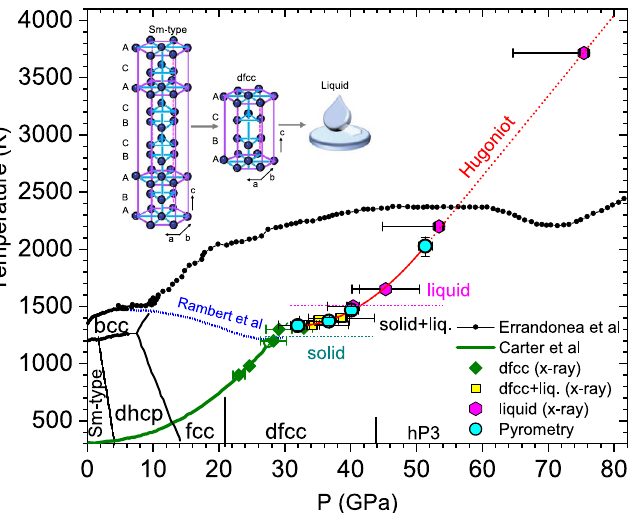
Figure 9. Proposed phase diagram of Samarium showing the solid-liquid phase boundaries. The uncertainties in pressures are presented in Table 1. Cyan circles are measured temperatures from pyrometry measurements. Green diamonds represent the solid dfcc phase, the yellow squares are the dfcc+liquid phase, and the magenta hexagons are the liquid phase from current XRD study. Small filled circles indicate the DAC melt curve proposed by Errandonea et al. 14 . The solid black lines are phase boundaries from various DAC studies 11,13 . Blue dashed line is the proposed melting curve by Rambert et al 13 . The green curve is the Hugoniot from a previous shock study 15